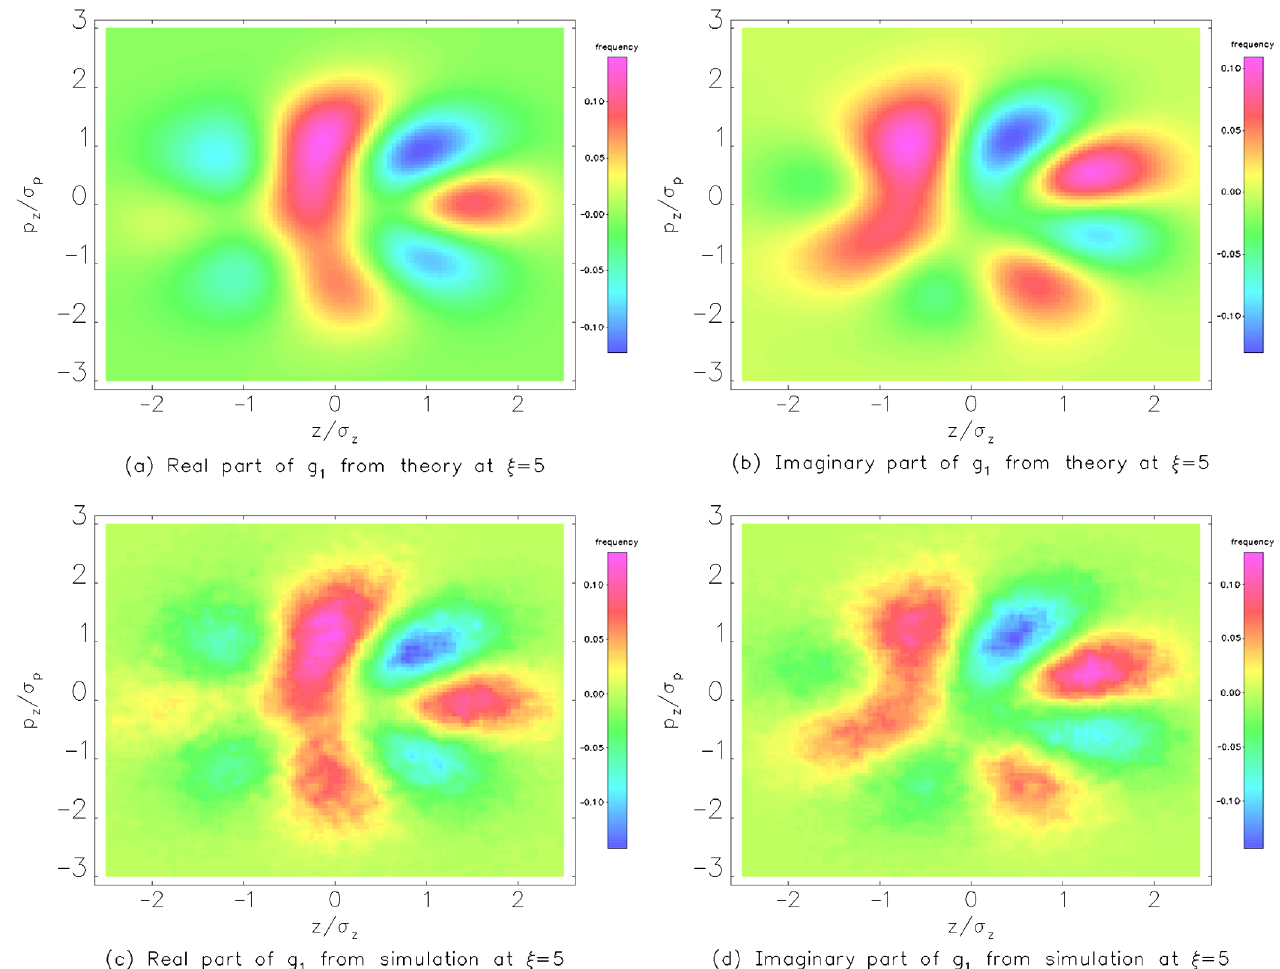
FIG. 4. Comparison of the real and imaginary parts of the longitudinal distribution function ~ g 1 obtained theoretically [(a) and (b)] and via simulation [(c) and (d)] at a chromaticity of 5 units. As indicated by the four pairs of lobes, the growing mode is dominated by the azimuthal mode number m ¼ − 4 ; theory indicates that ∼ 70% of the mode content has m ¼ − 4 , while ∼ 20% has m ¼ − 2 , m ¼ − 3 , or m ¼ − 4 . These plots map the variation in the longitudinal plane of the unstable betatron oscillation; at this turn in the simulation the betatron amplitude is about twice the rms beam size at equilibrium, while the maximum longitudinal variation is a little less than σ